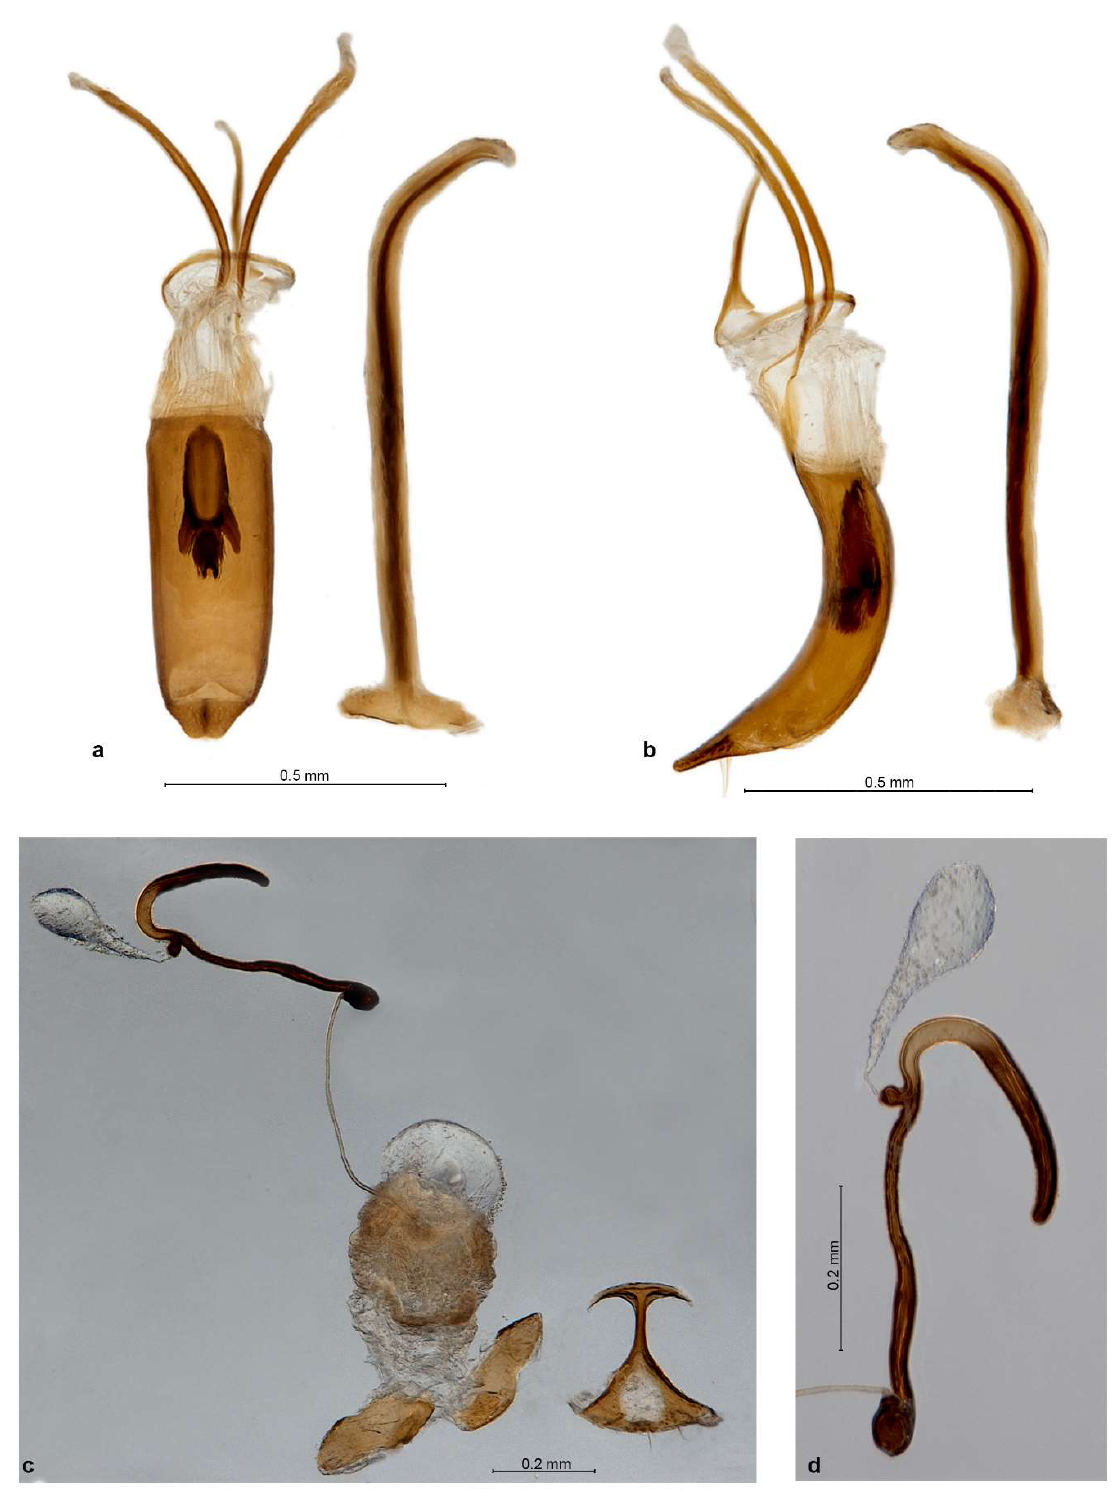
Figure 3. Philetaerobius nidicola Marshall, genitalia. ♂ (Gannapoort), aedeagus and sternite IX, dorsal view ( a ); ditto, left lateral view ( b ); ♀ (Springbok), ovipositor and sternite VIII, dorsal view ( c ); spermatheca, dorsal view ( d ).